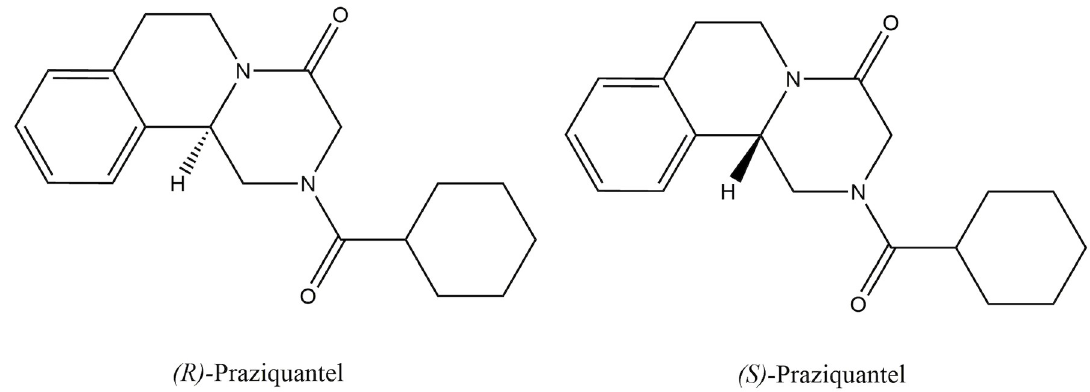
Fig 1. The molecular structure of the two PZQ enantiomers. The (R)-praziquantel has the hydrogen atom (H) pointing down from the chiral center. The (S)-praziquantel has the hydrogen atom (H) pointing up from the chiral center. PZQ, praziquantel.